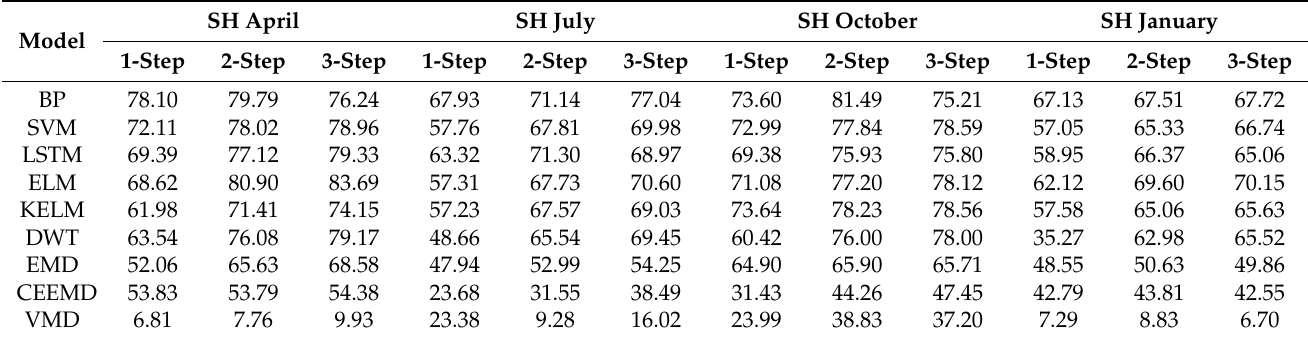
Table 8. Improvement percentages of the proposed